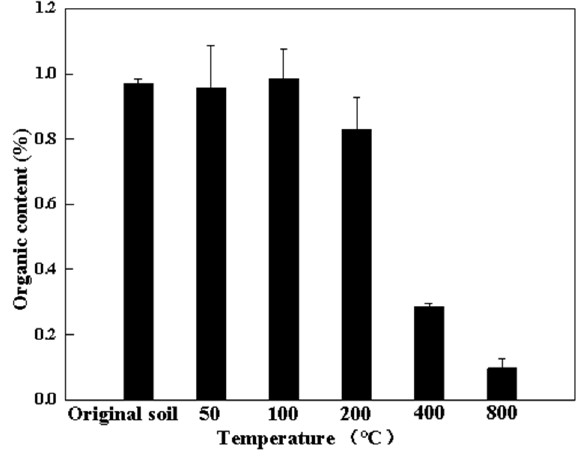
Figure 4. Content of organic matter in soil during thermal remediation.